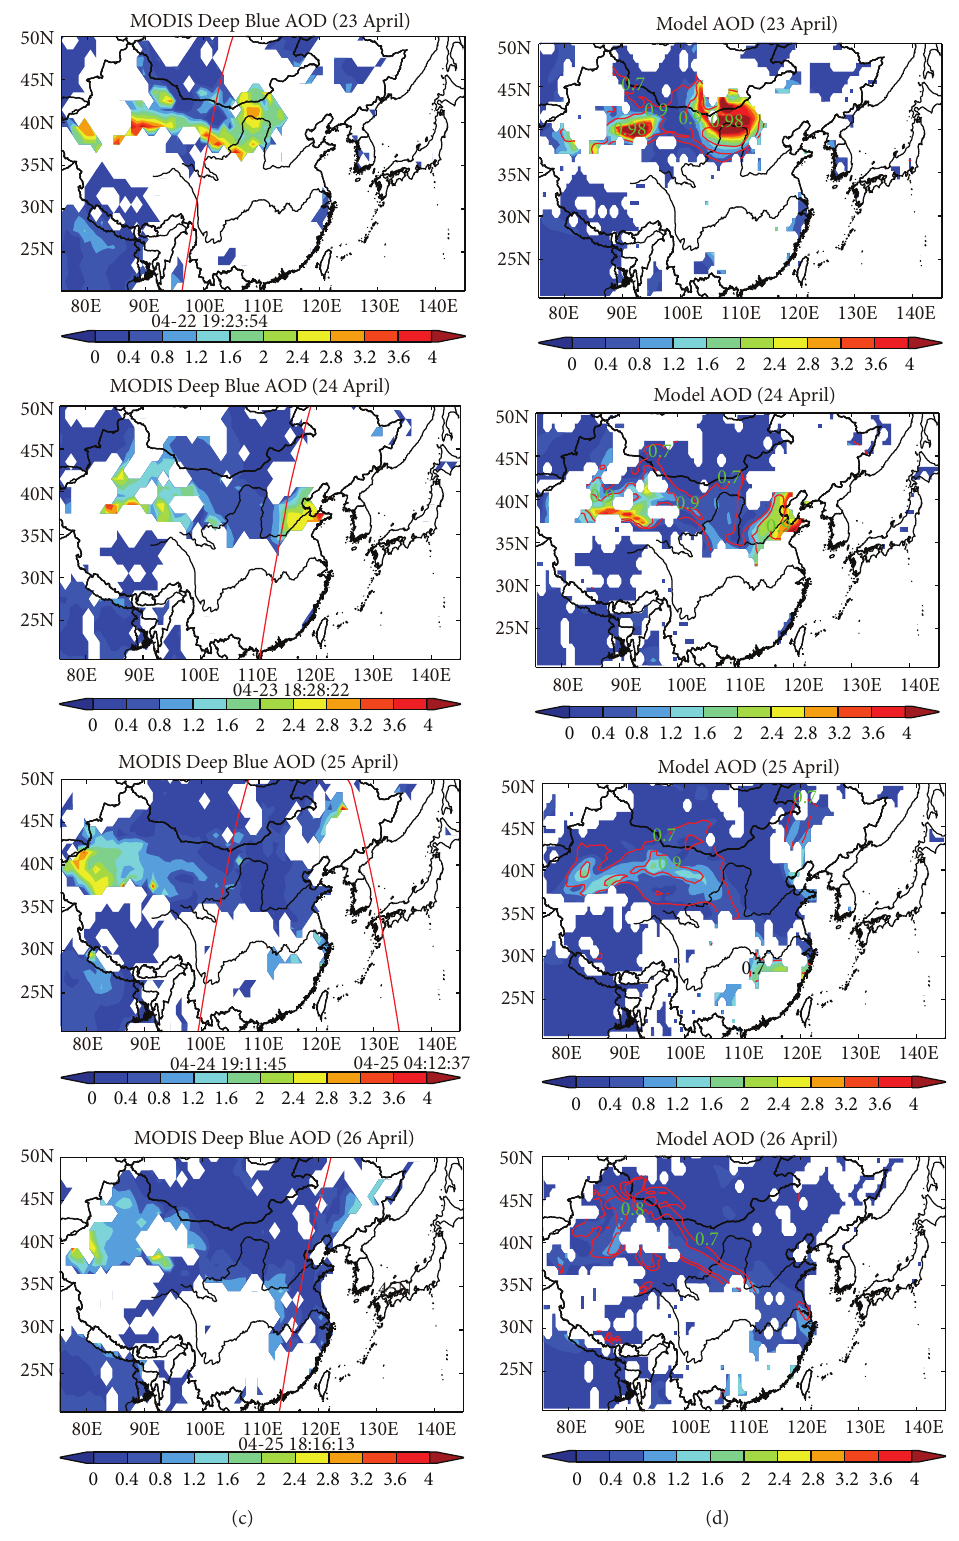
Figure 3: AOD from MODIS and the model at 550 nm during 23 to 26 April 2009 (LST): (a) MODIS Aqua “Land and Ocean” AOD product; (b) modeled AOD sampling according to (a); (c) MODIS Aqua “Deep Blue Land only” AOD product; (d) modeled AOD sampling according to (c). CALIPSO orbit paths (red lines) and path times (at the bottom of each path, UTC time, MM-DD HH:MM:SS) are presented in MODIS AOD figures ((a), (c)). Fractional contributions of dust to total AOD are indicated in modeled AOD figures ((b), (d), red contour lines with light blue